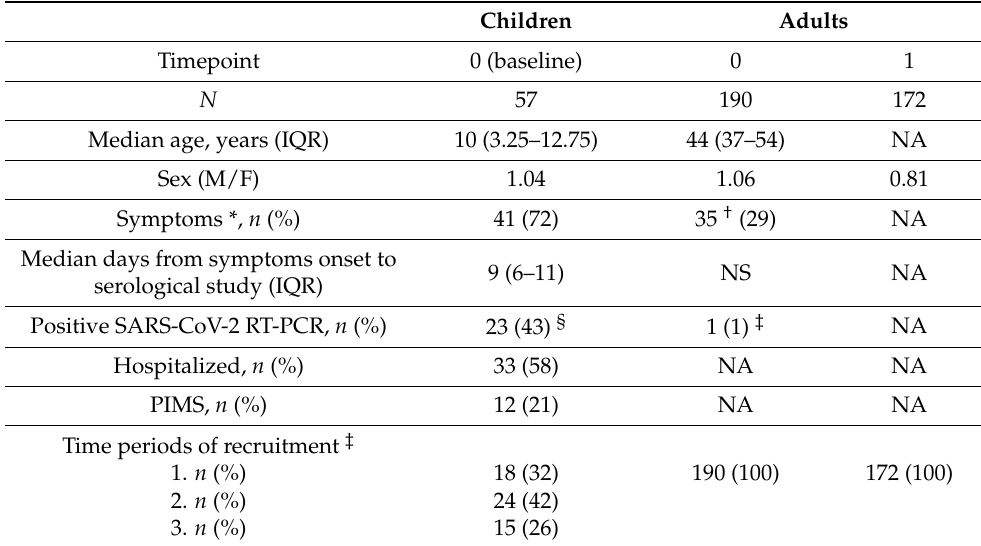
Table 1. Demographic and clinical characteristics of study